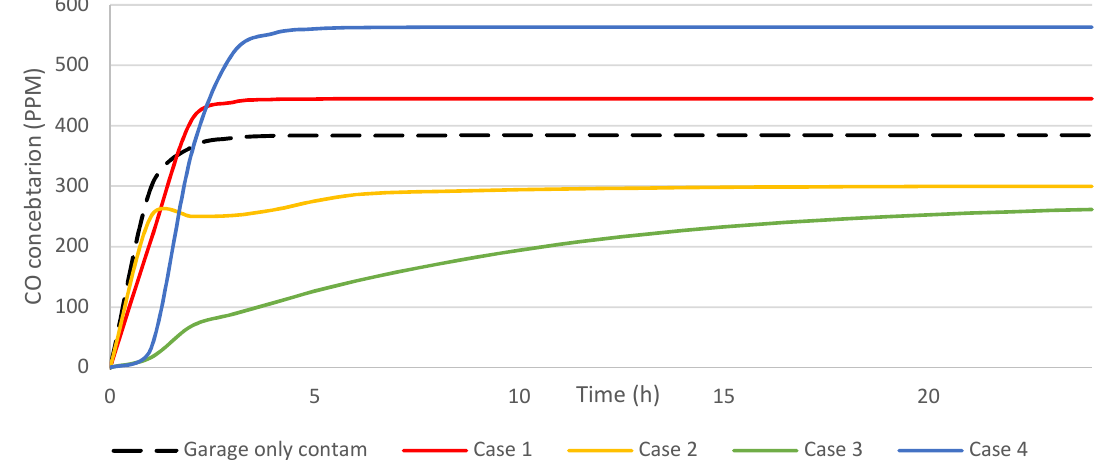
Figure 8. Coupled CONTAM and CFD0 results for the garage.